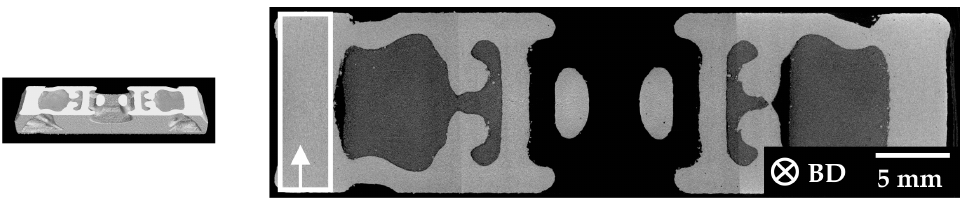
Figure 28. Single slice image of the manufactured design proposal for optimization case 2 of the developed optimization